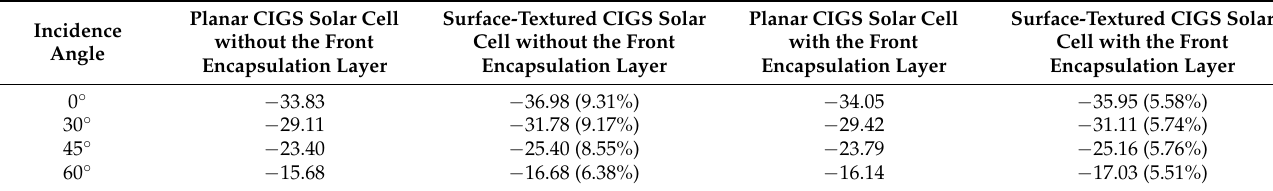
Table 1. Calculated short-circuit current density (J SC ) of the planar and surface-textured CIGS solar cells without and with the inclusion of the front encapsulation layers, which are taken from Figure 11. The unit of J SC is mA/cm 2 . The improvement percentage of J SC in the surface-textured CIGS solar cell over the planar CIGS solar cell is denoted in the parenthesis whether the front incoherent encapsulation layers are included or